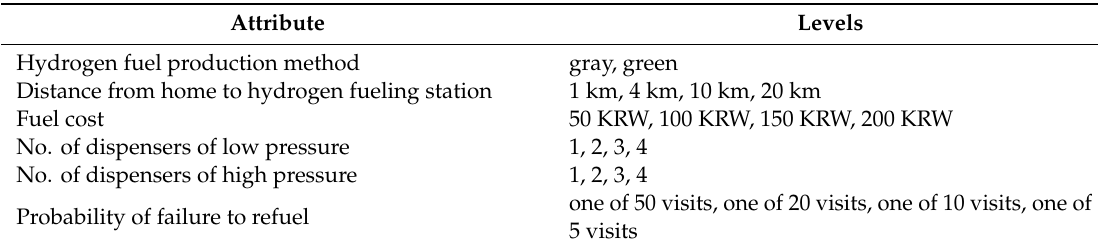
Table 2. Attributes and